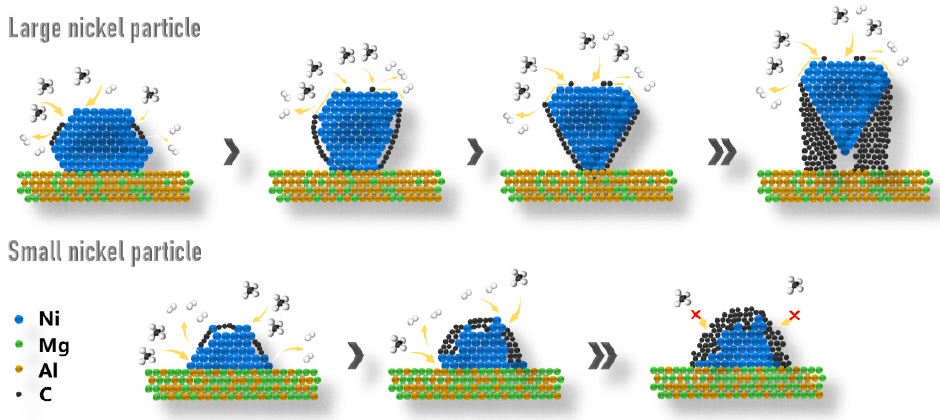
Figure 10. Schematic showing the possible mechanisms for carbon nanotube growing on large nickel particles and encapsulated carbon forming on small nickel particles.